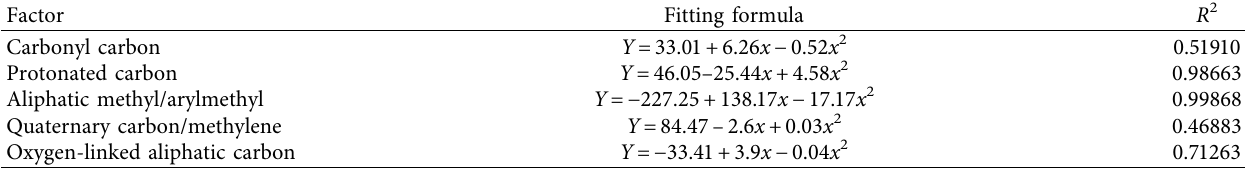
Table 10: Nonlinear correlation analysis of surfactant functional groups and